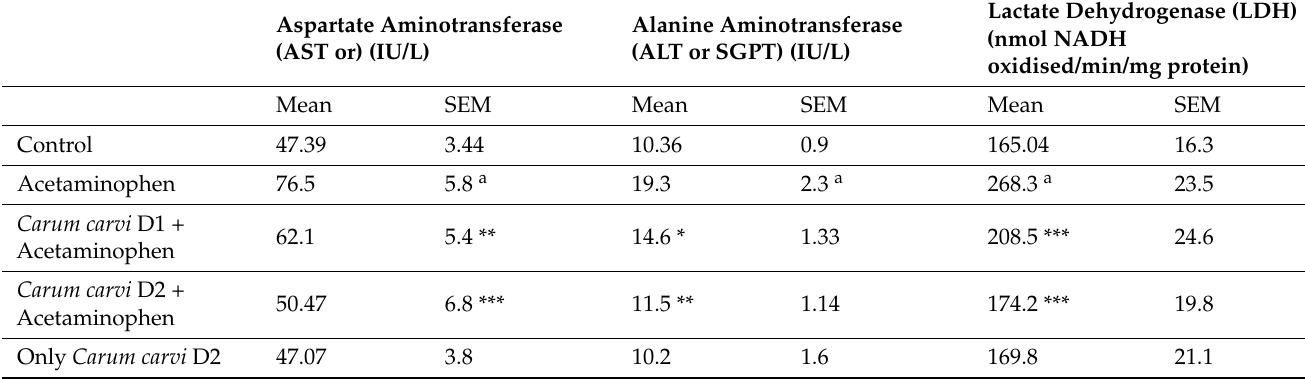
Table 4. Effect of Carum carvi treatment on restoring the acetaminophen-induced elevation in serum liver toxicity